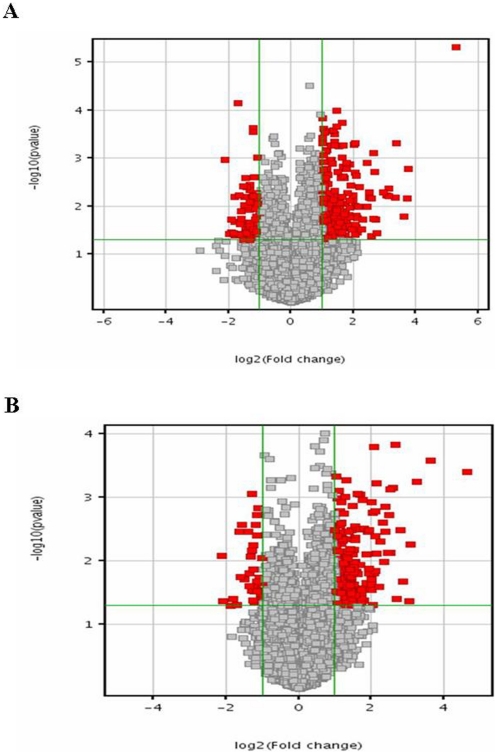
Volcano plot of differentially expressed transcripts.(A) Normal untreated vs normal rottlerin-treated fibroblasts. (B) SSc untreated vs SSc rottlerin-treated fibroblasts. A volcano plot of genes differentially expressed in human dermal fibroblasts exposed to rottlerin. The X-axis represents the log2 values of the fold change observed for each transcript whereas the Y axis depicts the log10 values of the p value of the significance tests between replicates for each transcript. Genes that demonstrate a 2 fold or greater difference in expression at a p value<0.05 in rottlerin treated cells compared to untreated cells are displayed in red. Dots representing genes of interest validated by RT-PCR are labeled.